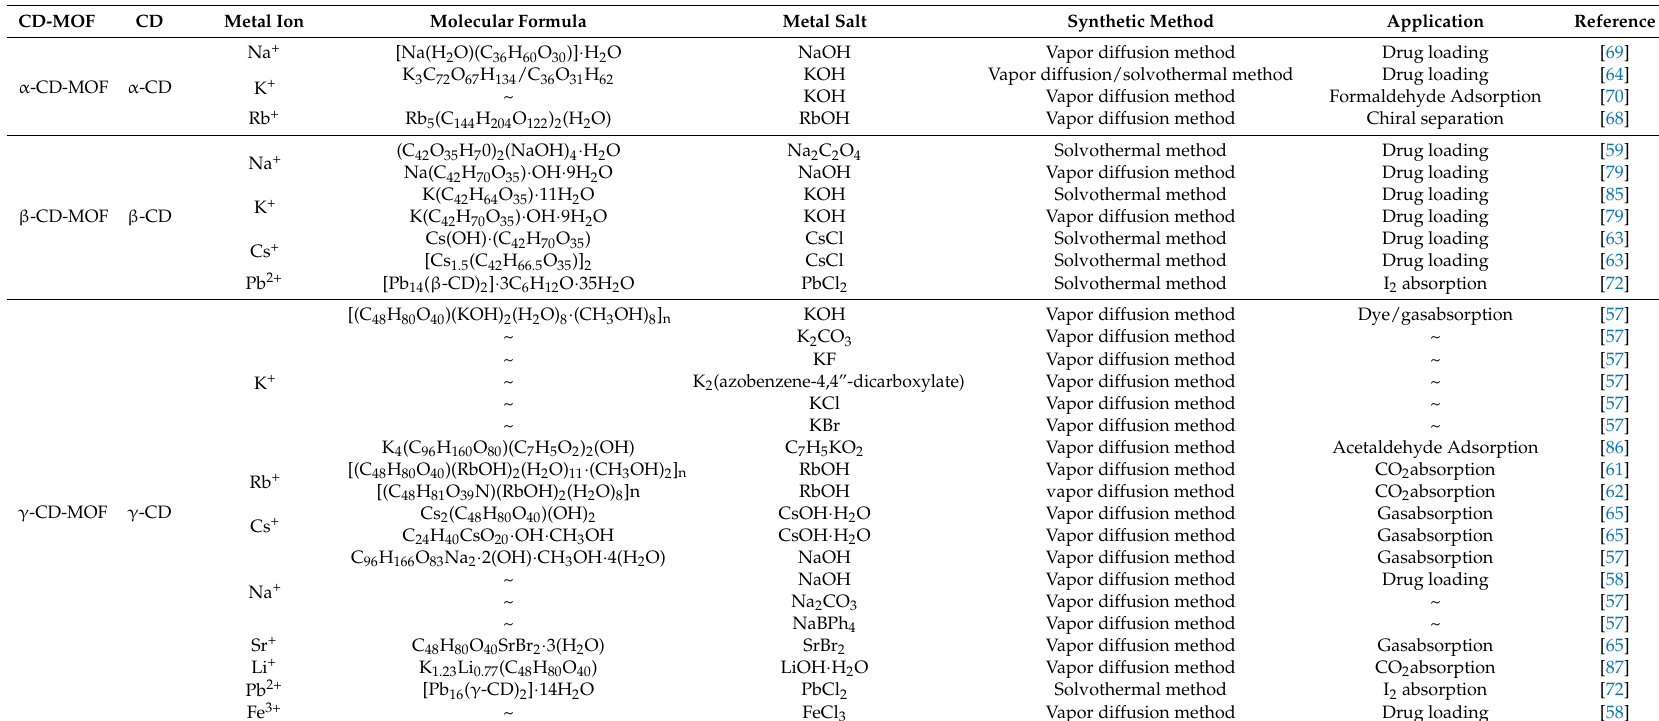
Table 1. Examples of CD-based metal-organic frameworks